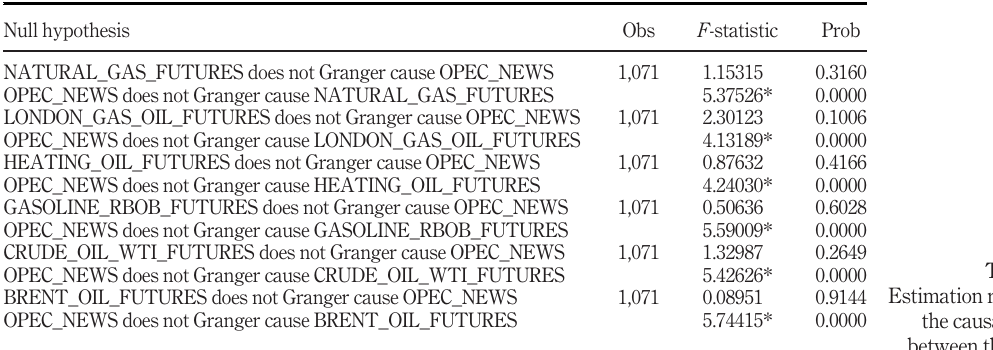
Figure 18. The quantile process estimates for OPEC